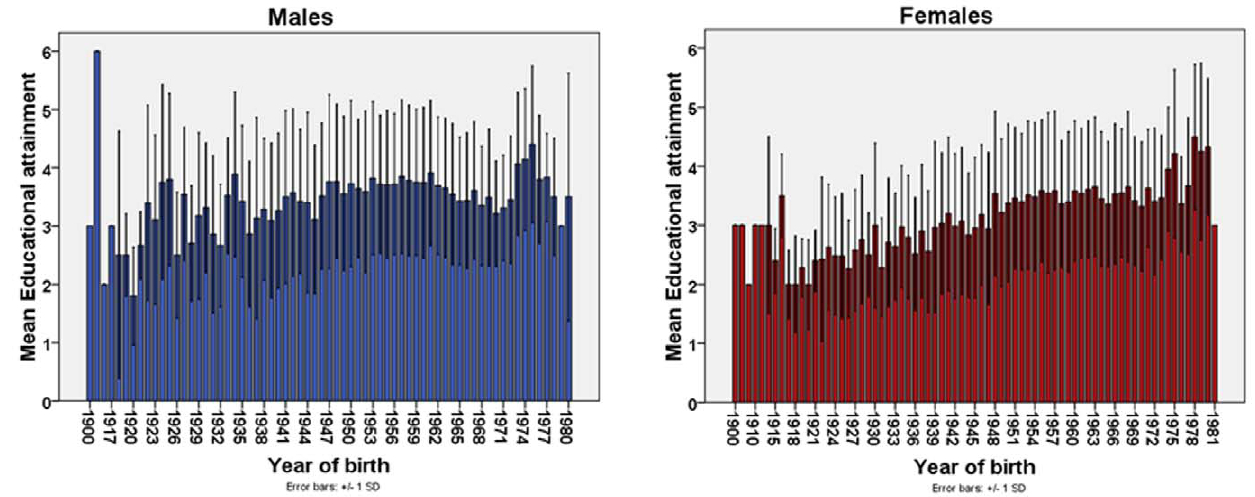
Figure 2. Mean educational attainment (EA) by year of birth in male and female.